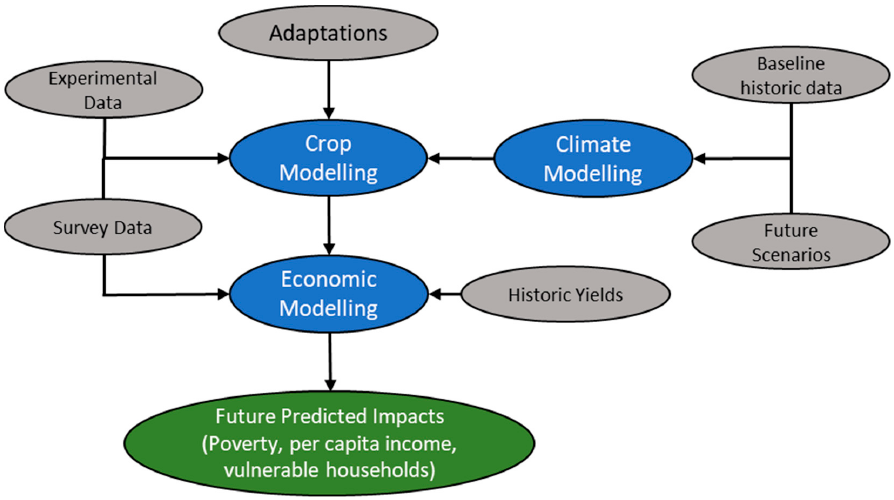
Figure 2. Methodological framework—climate, crop, and economic models’ integration.